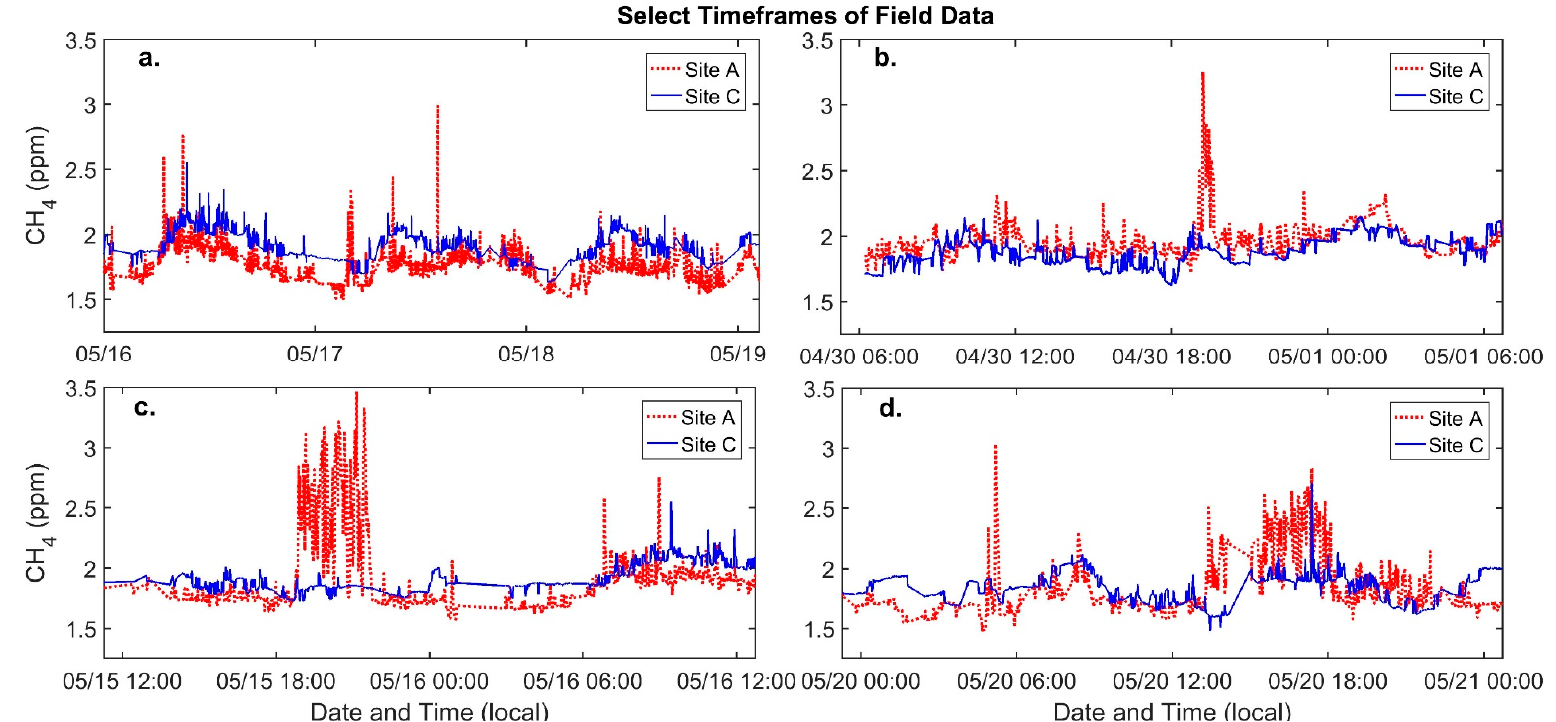
Figure 3. Select timeframes of field data that illustrate relatively large differences in methane between Sites A and C. ( a ) a period of four days including several examples of enhanced methane; ( b ) a 24-h period including an approximately 1 ppm increase in methane; ( c ) a 24-h period depicting an approximately three-hour long methane enhancement; ( d ) a 24-h period including several enhancements in methane.